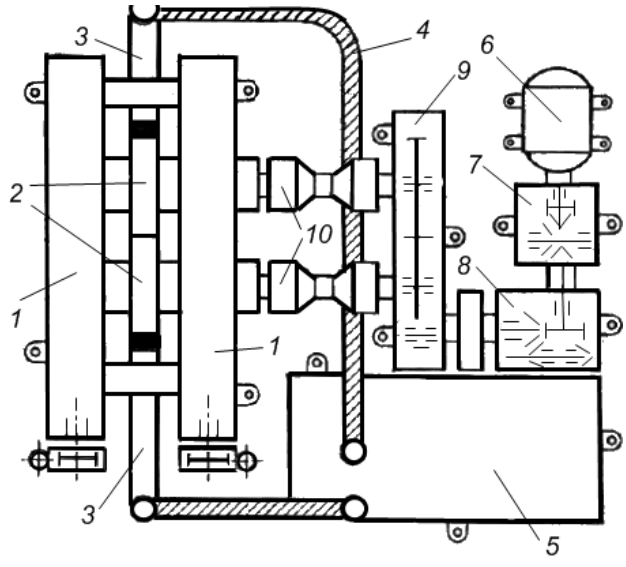
Figure 21. Schematic of the set-up for electric pulse sintering of powders during